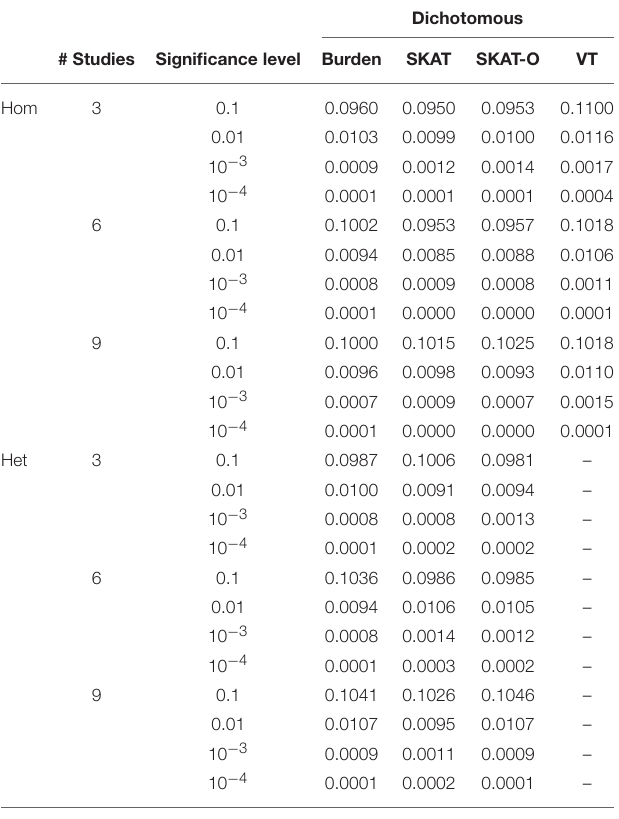
TABLE 1 | Type-1 error estimates from simulation study with dichotomous